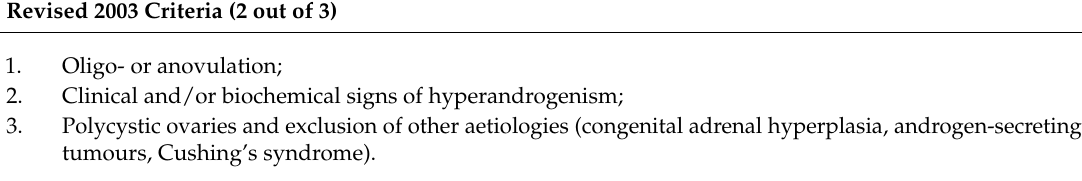
Table 1. The international evidence-based guideline for the assessment, diagnosis and management of polycystic ovary syndrome (PCOS) endorsed the Rotterdam diagnostic criteria in adults [1]. Revised 2003 Criteria (2 out of